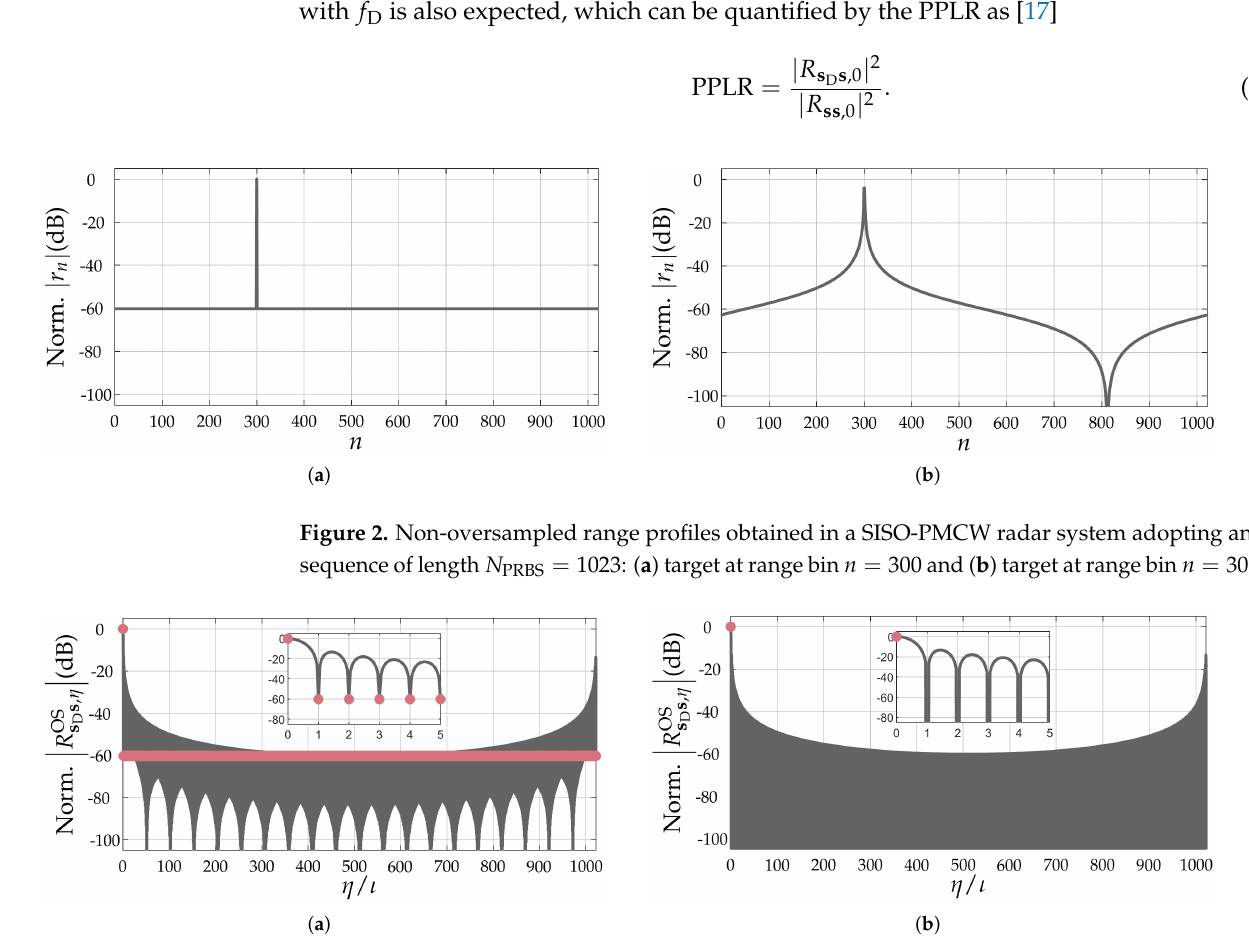
) and oversampled ( — , ι = 20) PACFs: ( a ) PACF (cid:32)